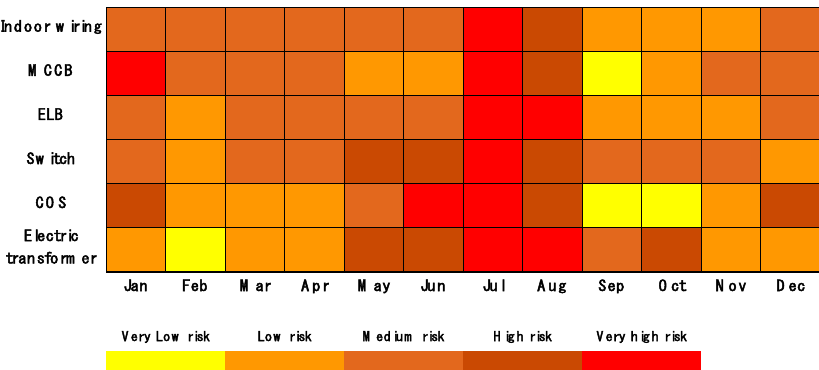
Figure 21. Risk matrix diagram of the electrical fires by equipment and month.